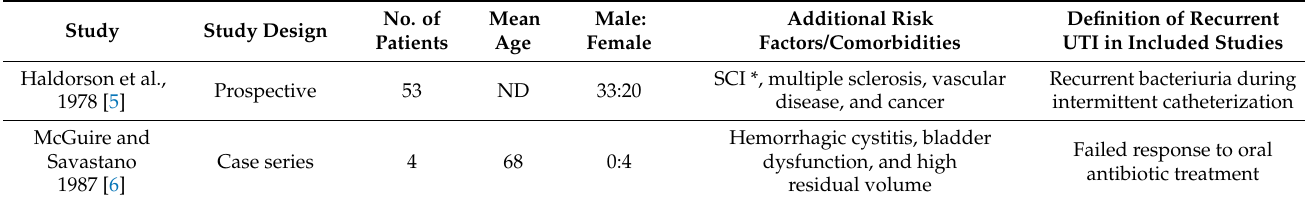
Table 1. Characteristics of studies on the use of intravesical aminoglycoside for